Question: Draft a figure caption describing what is shown.
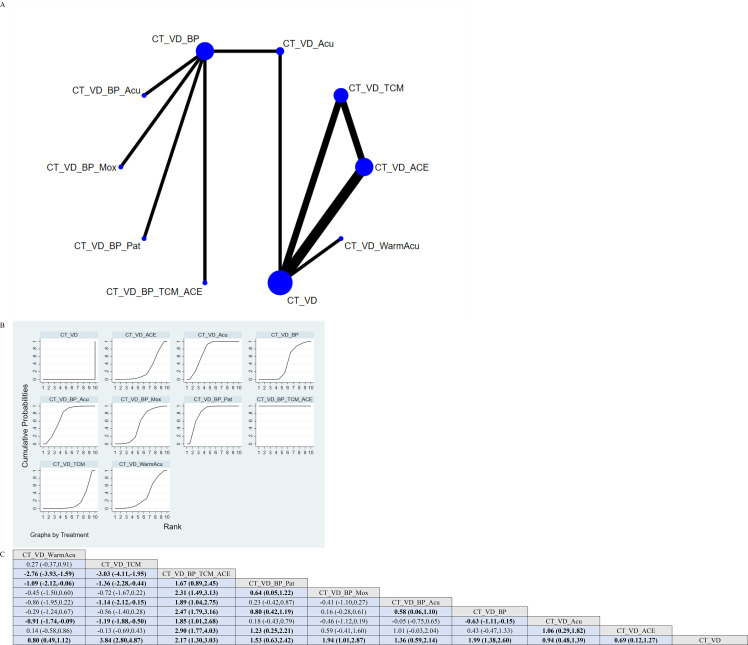
Answer: Network meta-analysis of E2 (A) Network plot of the network meta-analysis for E2. (B) Rankogram of overall intervention strategies from the network meta-analysis for E2. (C) League table of the network meta-analysis for E2.